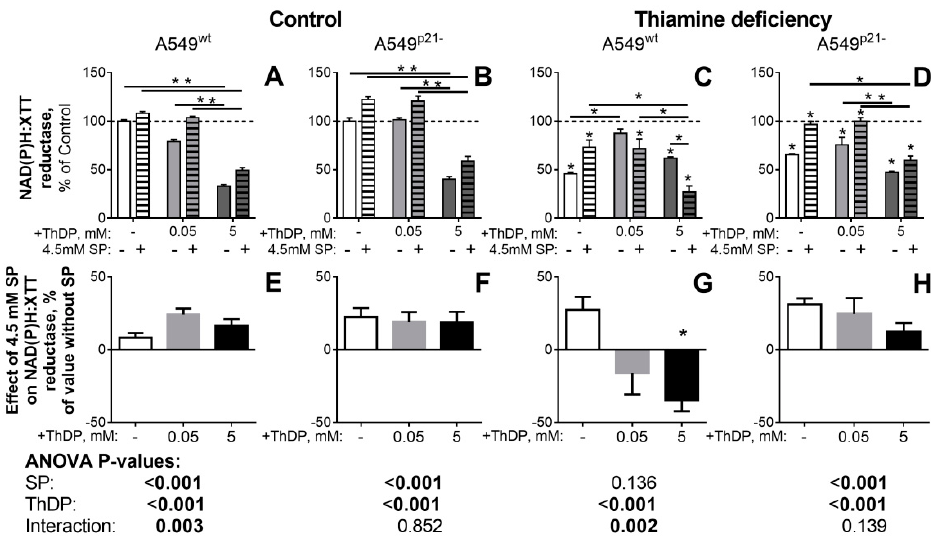
Figure 4. Influence of the OGDHC inhibitor SP on p21-dependent responses of NAD(P)H:XTT reductase activity of A549 cells to variation in the thiamine / ThDP levels. A549 wt ( A , C , E , G ) or A549 p21- ( B , D , F , H ) cells were cultured in DMEM prepared with 4 mg / L thiamine hydrochloride (Control, A, B, E, F) or without thiamine (Thiamine deficiency, C, D, G, H). 24 h after supplementation with indicated concentrations of ThDP (shades of grey) and / or SP (4.5 mM, hatched columns), NAD(P)H:XTT reductase activity was assayed. Values obtained without ThDP supplementation are presented by white columns, those at 0.05 or 5 mM ThDP—by gray or black columns, correspondingly. In the upper part (A–D), cellular NAD(P)H:XTT reductase activity is normalized to the activity of the control A549 wt or A549 p21- cells to show the combined e ff ects of thiamine / ThDP and SP on cellular viability. In the lower part (E–H), cellular NAD(P)H:XTT reductase activity is normalized to the corresponding value without SP to show the specific e ff ect of SP under each the varied thiamine / ThDP levels. The data of at least three independent experiments are presented as mean ± SEM. Statistically significant di ff erences ( p < 0.05, shown by asterisks) are determined by two-way ANOVA followed by Tukey’s post hoc test. Horizontal lines show the groups compared. Asterisks above the bars in C and D indicate the statistically significant di ff erences between the corresponding thiamine deficient cells and cells with the standard thiamine level. Asterisk in G indicates the statistically significant e ff ect of SP vs the same condition without SP. ANOVA significances of the factors (SP and ThDP) and their interactions are given below the graphs, with significant ( p < 0.05) values in bold.